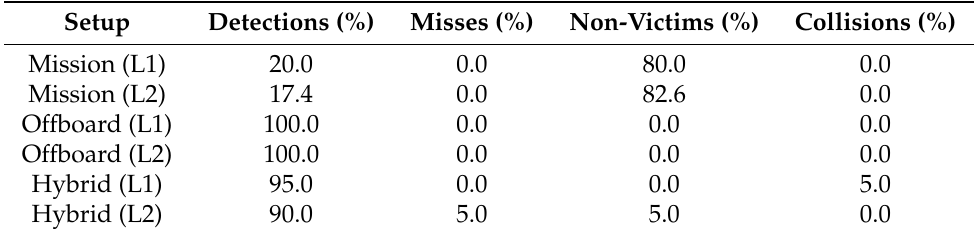
Table 5. Accuracy and collision metrics of the system to locate a victim at two locations (L1 and L2). Each setup was evaluated for 20